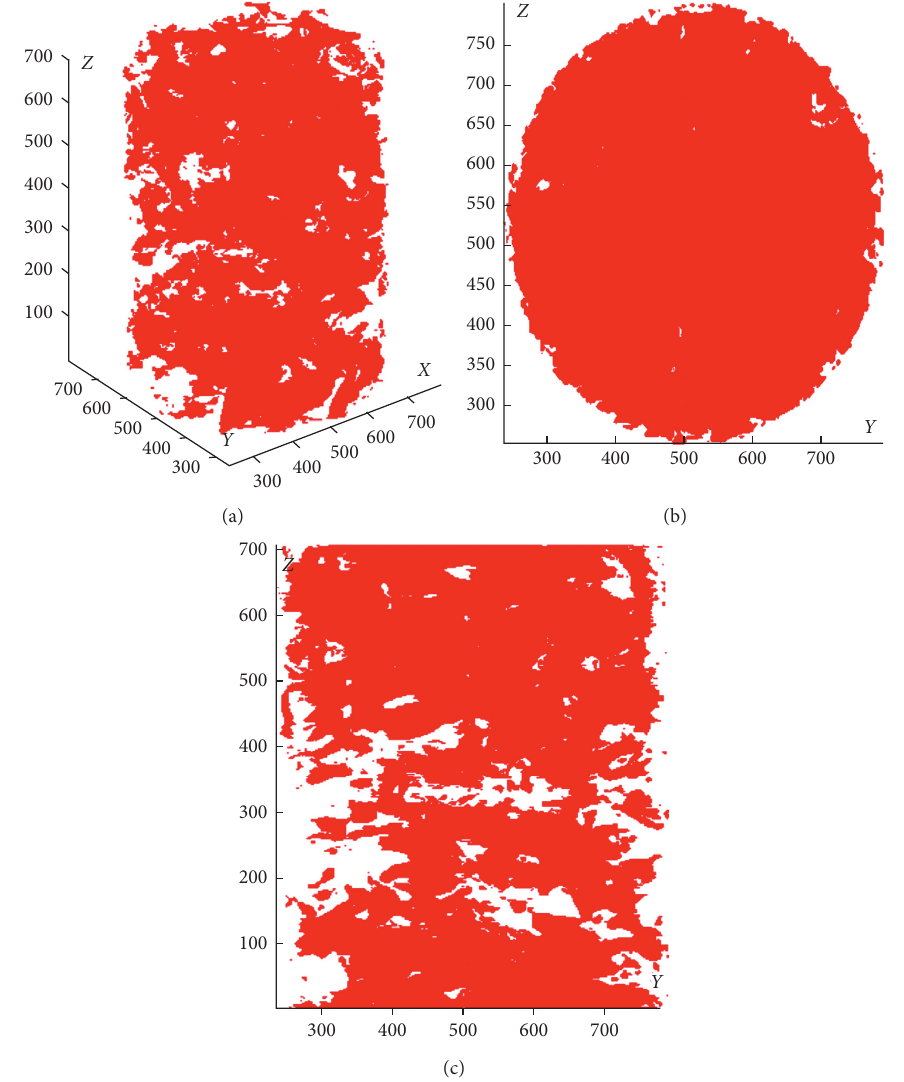
Figure 15: Air void distribution of SMA13 specimen. (a) Three dimensions. (b) Projection in transverse section. (c) Projection in vertical